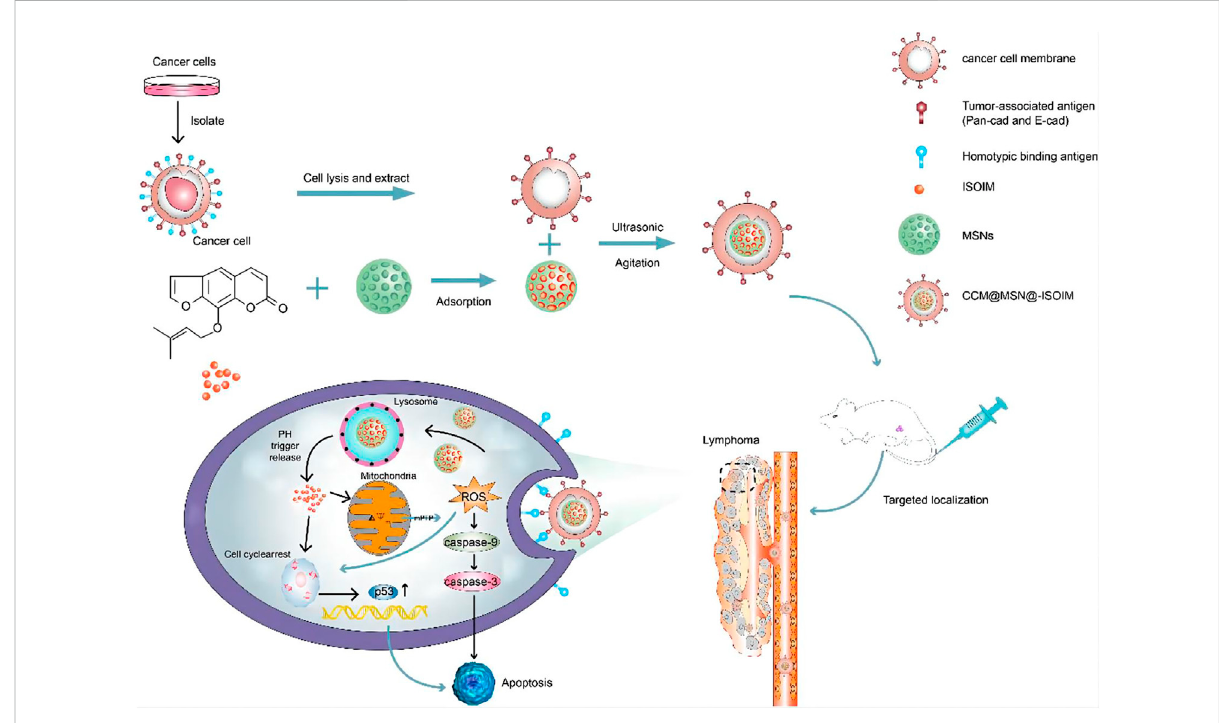
FIGURE 2 The scheme diagram of CCM@MSNs-ISOIM construction and its targeted therapeutic mechanisms in lymphoma (Zhao et al., 2021). In this work, a nano-platform based on MSNs which camou fl aged by the cancer cell membrane was constructed. The nano-platform has the characteristics of anti-phagocytosis, high drug-loading capacity, low pH sensitivity, good biocompatibility and active targeting, promoting mitochondrial-mediated